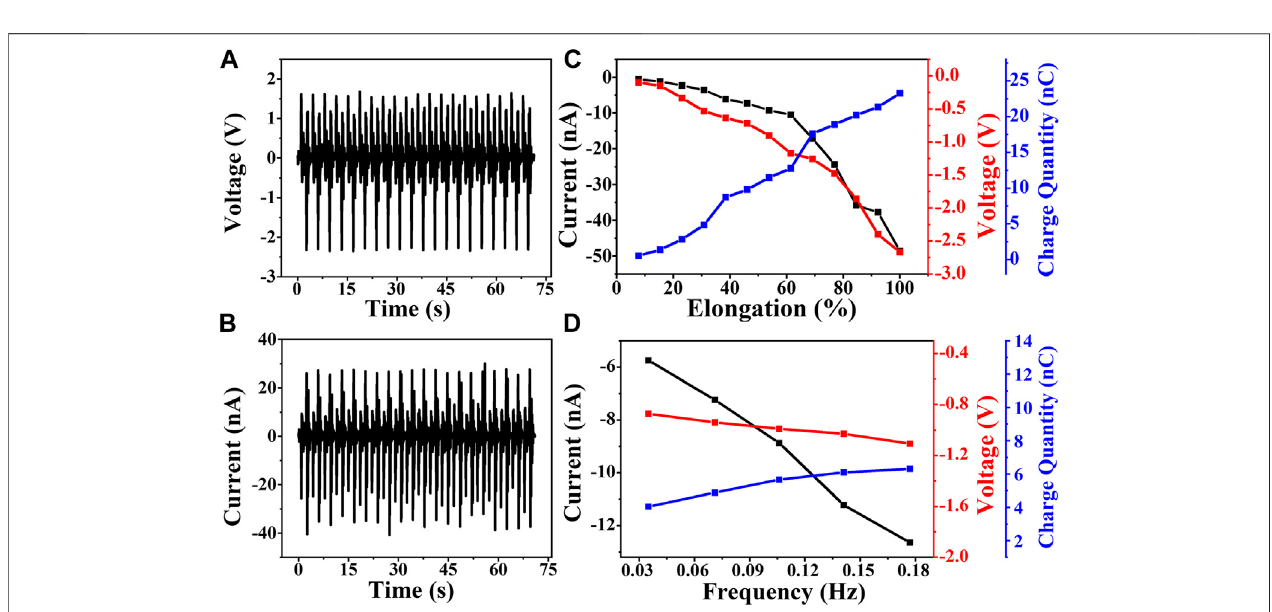
FIGURE 2 | Output performance of the TENG under different conditions. (A,B) Voltage and current curves at 90% strain and 0.28 Hz. (C) Current, voltage, and charge quantity value with different strains at 0.28 Hz. (D) Current, voltage, and charge quantity value with different frequencies at 60% strain.